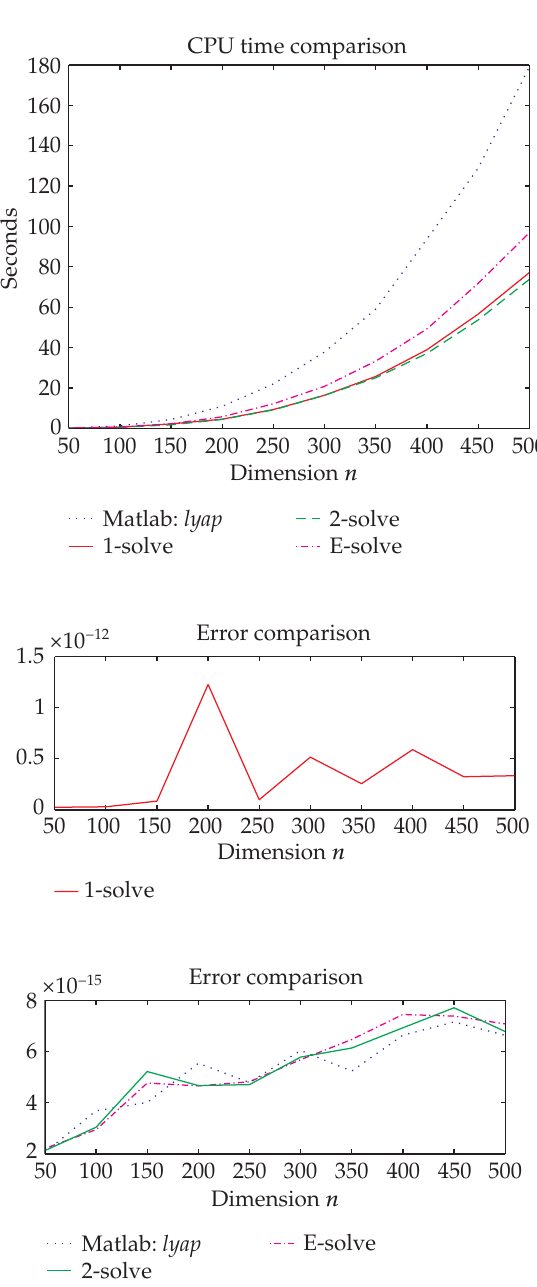
Figure 2.1 . Comparison of performance for Sylvester equation ( 2.34 )